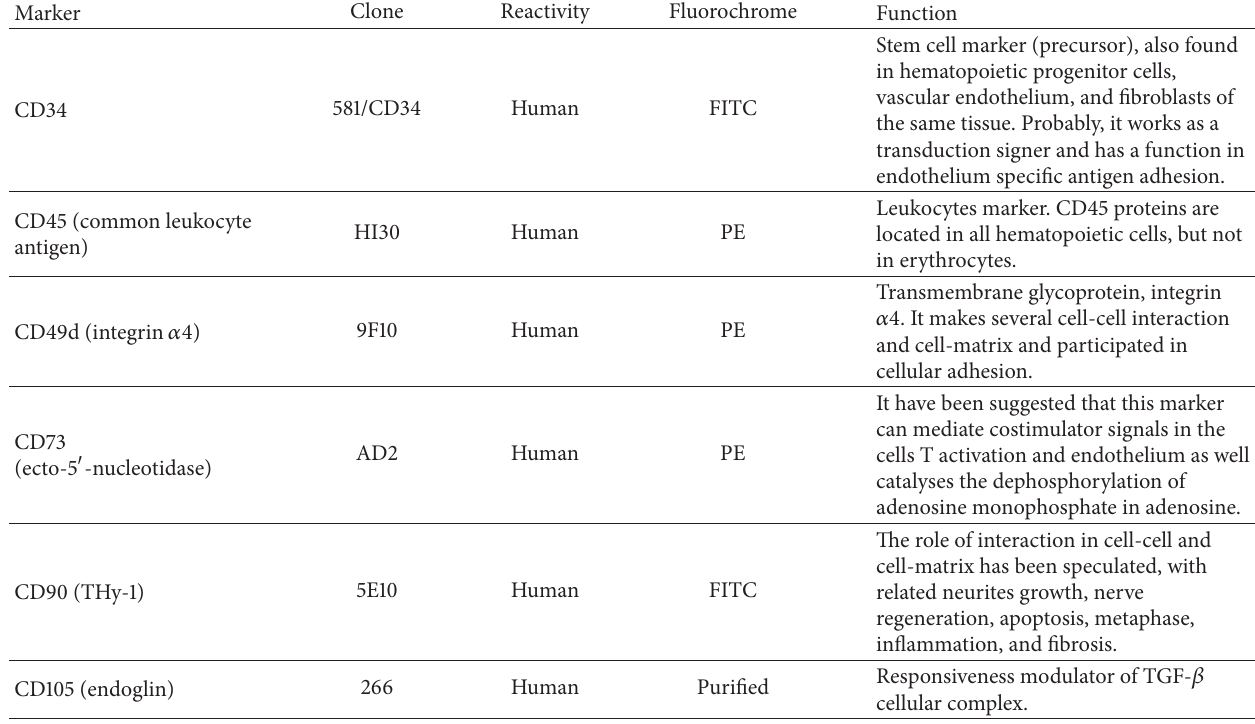
Clone Reactivity Fluorochrome Function 581/CD34 FITC